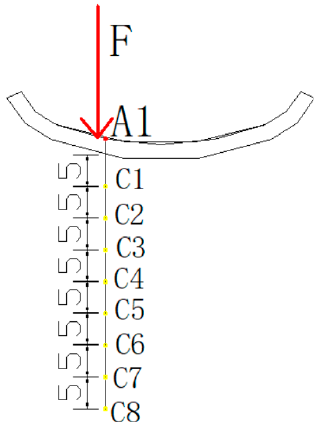
Figure 10. The layout of soil pressure cell (cm).